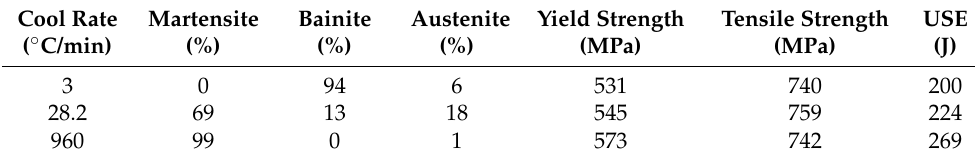
Table 7. Fraction of tested materials with different cooling rates and tensile properties [54]. Cool